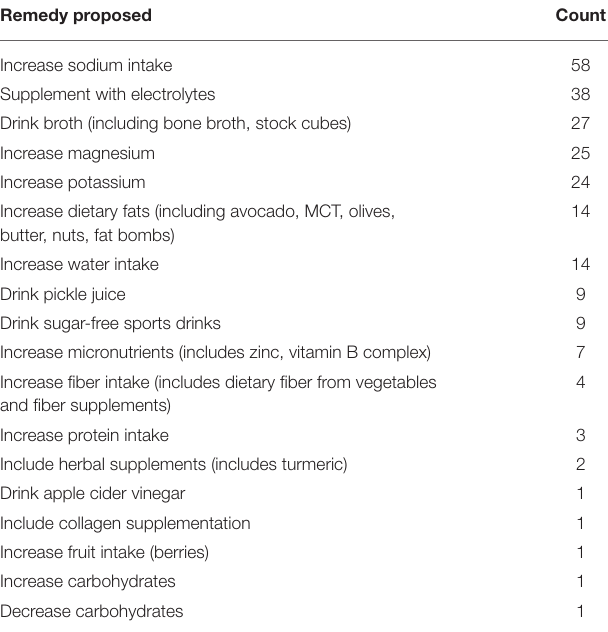
TABLE 2 | Remedies for keto flu proposed by users online forum posts, and